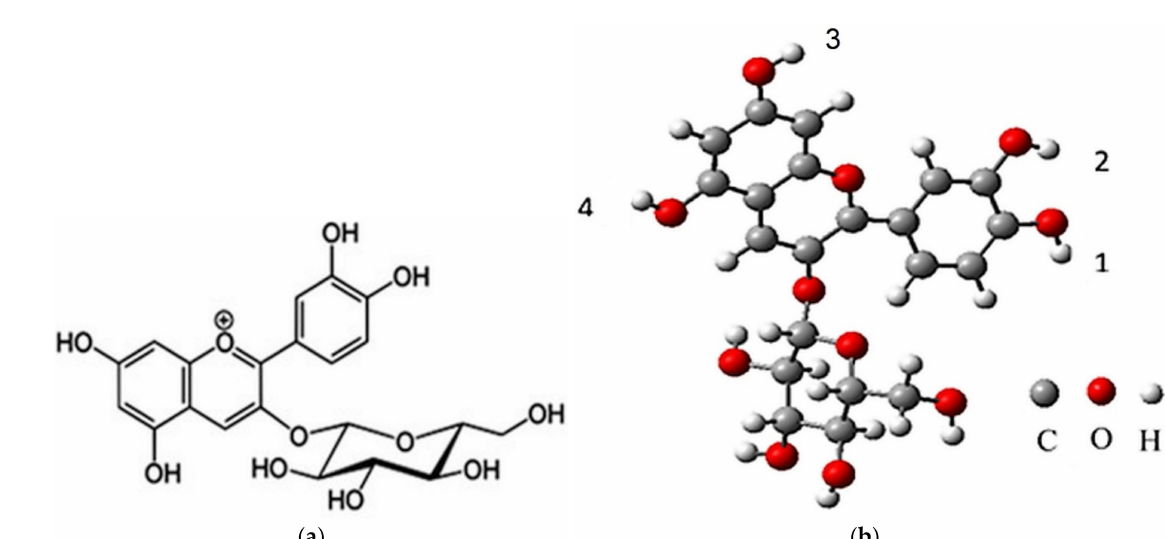
Figure 1. Cyanidin 3-glucoside structure ( a ) and labeling of the deprotonation sites ( b ).